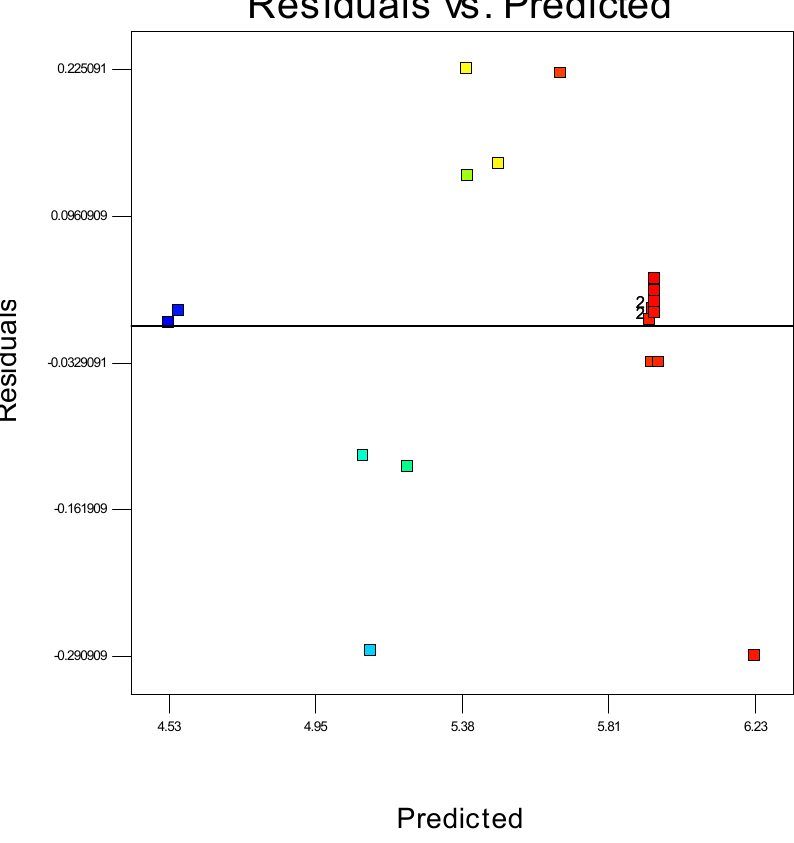
Figure 10. The residuals and predicted response plot for propylene polymerisation.